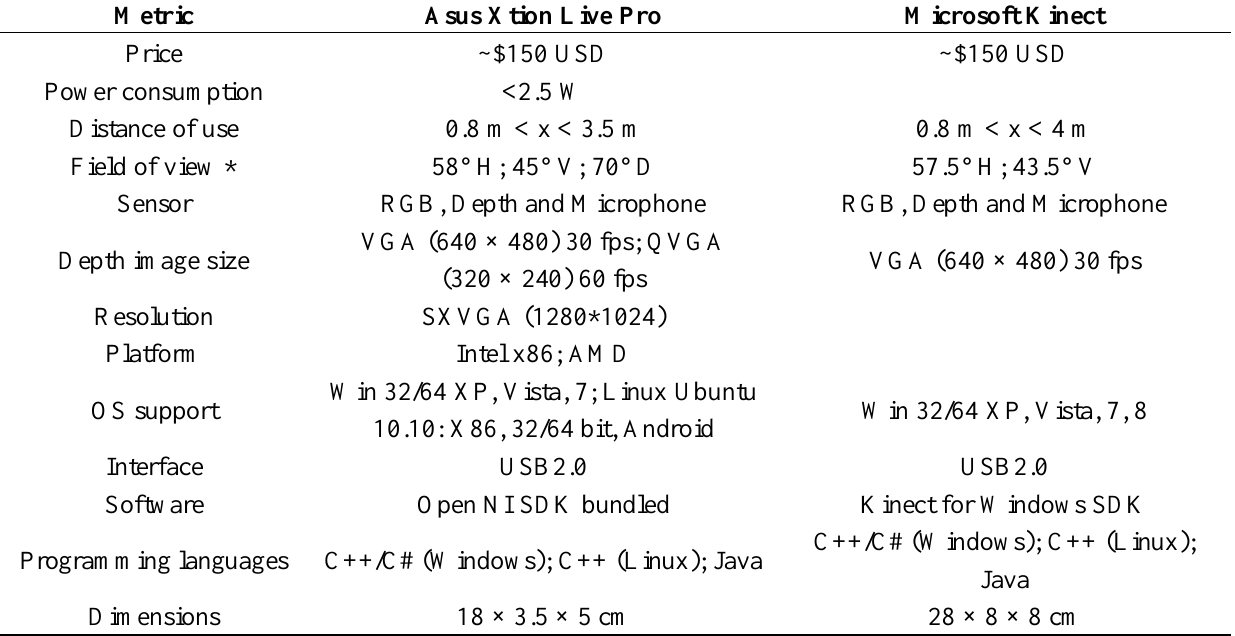
Table 1. Specifications and comparison of Asus Xtion Pro Live and Microsoft